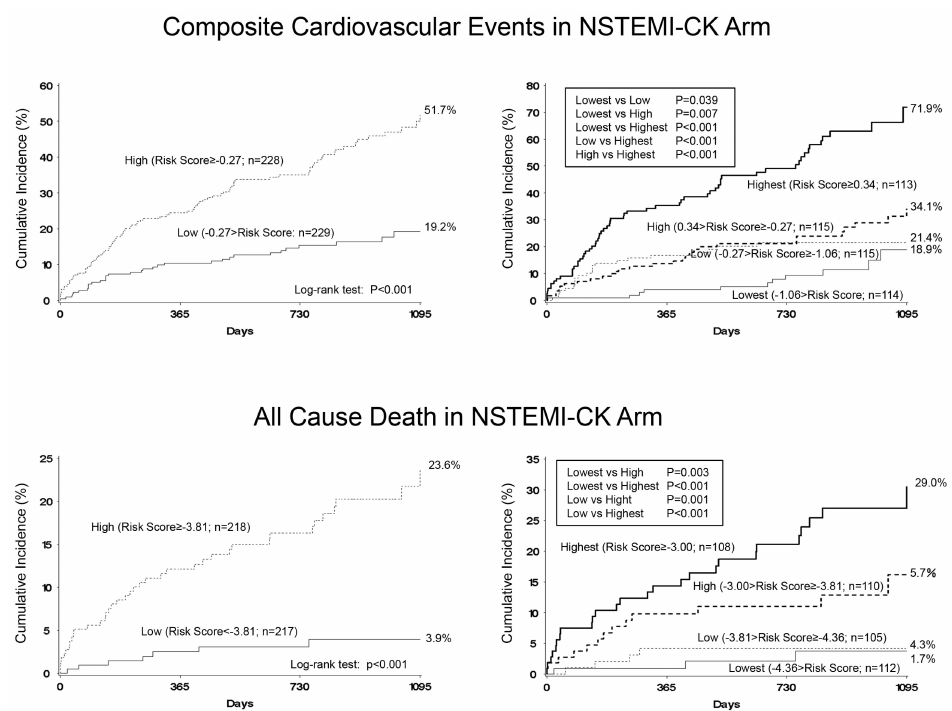
Figure 3. Incidence of composite cardiovascular events and all-cause death in patients with NSTEMI-CK. Two-group comparison based on the median values of risk scores (high or low) ( left ) and four-group comparison based on the quartile values of risk scores (highest, high, low, or lowest) ( right